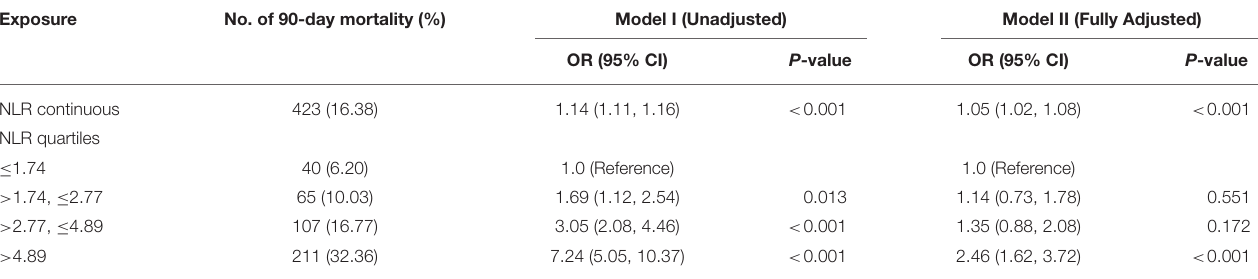
TABLE 2 | Relationship between NLR and 90-day transplant-free mortality. Exposure